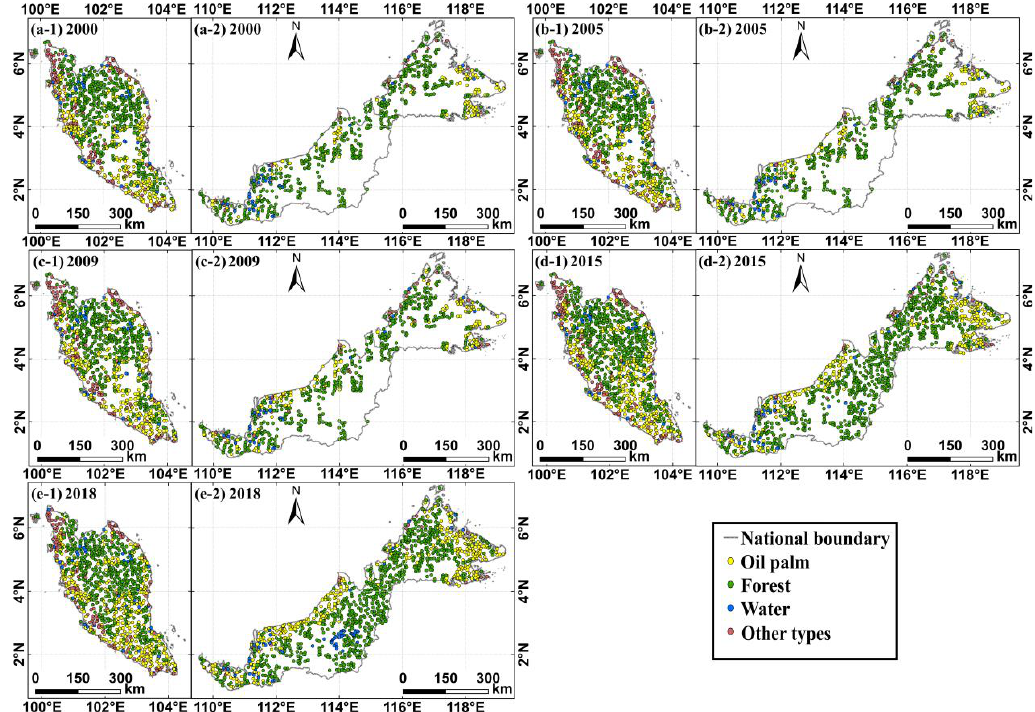
Figure 3. Distribution of the Malaysian sample points. The letters a, b, c, d, and e represent 2000, 2005, 2009, 2015, and 2018. The numbers 1 and 2 represent West Malaysia and East Malaysia, respectively.